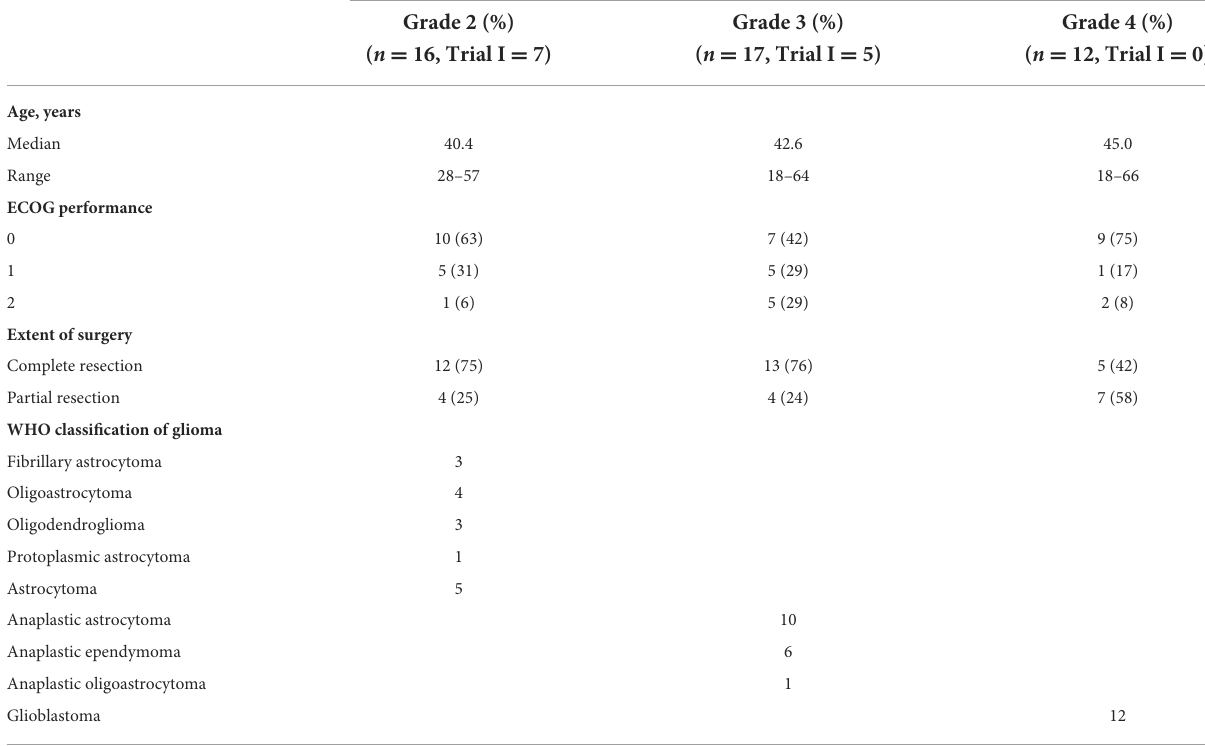
TABLE 1 Patient baseline characteristics and treatment